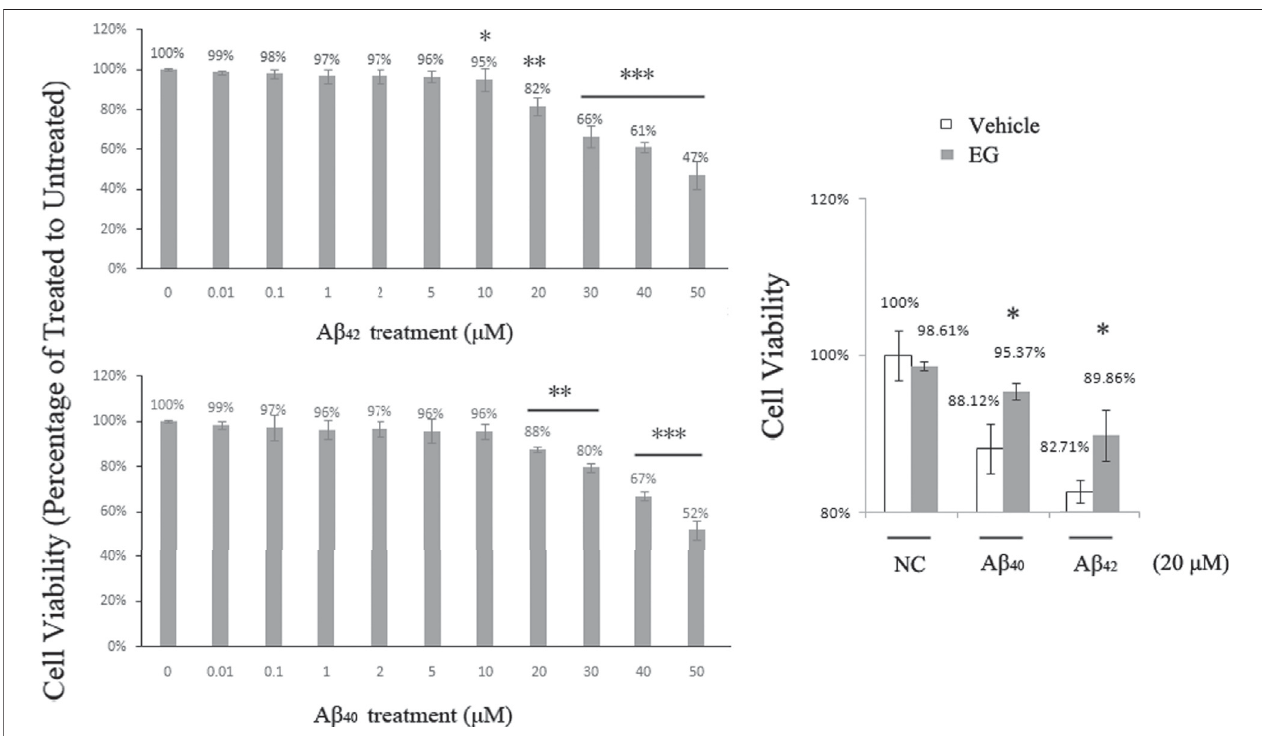
FIGURE6| Neuronal death induced byA β peptides wasalleviated byEG. (A) PC12 cells treated withamyloid peptidesA β 42 (upper) and A β 40 (lower) for 24 h, at gradient concentrations from 0.01 to 50 μ M, followed by Cell Counting Kit-8 (CCK-8) assay for viability. (B) PC12 cells pre-treated with (gray bar) or without (white bar) EG at 10 − 7 M for 18 h, then further subjected to 20 μ M fi nal concentration of amyloid peptides A β 40 and A β 42 for 24 h followed by CCK-8 assay for viability. The mean values ( ± S.D.) of three independent experiments are shown. An asterisk indicates statistical signi fi cance (* p < 0.05, ** p < 0.001, *** p << 0.001). EG: emodin-8-O- β - D -glucopyranoside; NC: negative